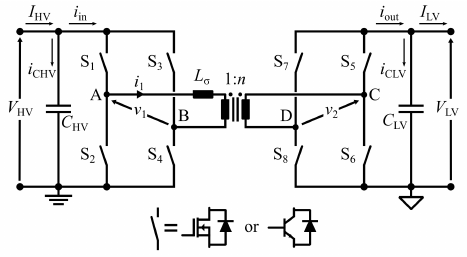
Figure 1. Schematic of DAB converter.